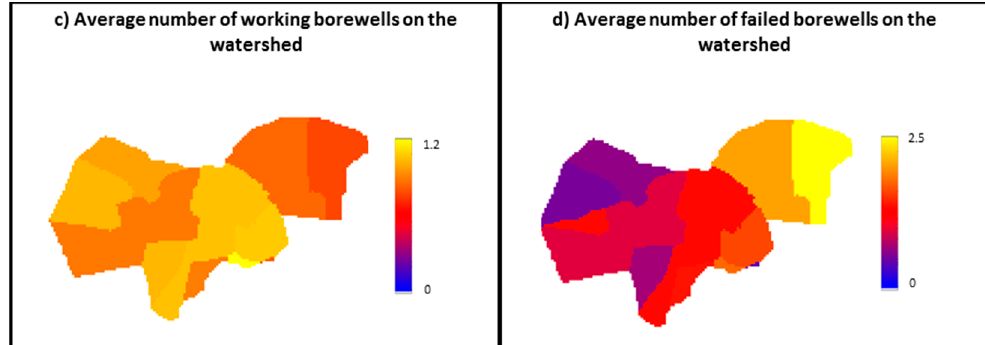
Figure 3. Distribution of irrigated farms and number of borewells per farm on the watershed. The maps present for the 12 villages ( a ) the distribution of irrigated farms; ( b ) the average number of borewells drilled per farm; ( c ) the average number of working borewells per farm and ( d ) the average number of failed borewells per farm.